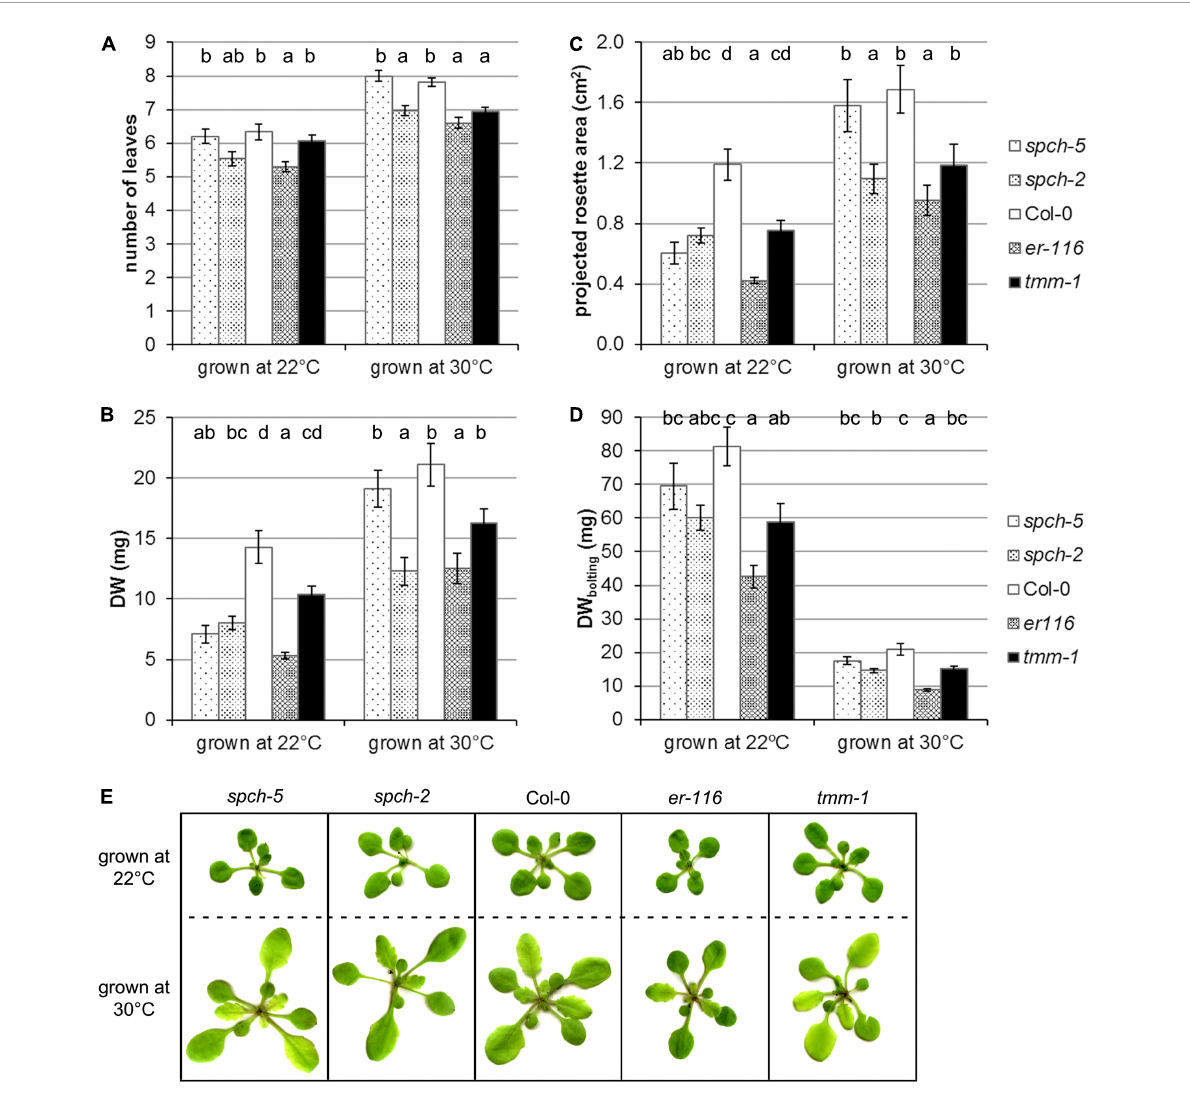
FIGURE3 Supra-optimal temperature effects on the growth of selected genotypes. Plant growth was evaluated in terms of (A) number of leaves in the rosette, (B) dry weight, and (C) the projected plant area at 15 dag. (D) Dry weight at bolting (24 dag for 22 ◦ C and 18 dag for 30 ◦ C). (E) RGB images of plants of the same age (15 dag) grown at optimal conditions (22 ◦ C) or at supra-optimal temperature (30 ◦ C). Values are means ± SE ( n = 20). Different letters above the bars indicate statistically significant differences between genotypes at the same growth temperature ( p ≤ 0.05) by one-way ANOVA followed by Dunnet’s T3 (22 ◦ C data in panels B,C ; 30 ◦ C in panel D ) or the Tukey’s test (22 ◦ C data in panel D ), or by the Kruskal–Wallis test followed by the Dunn’s test (22 ◦ C data in panel A ; 30 ◦ C data in panels A – C